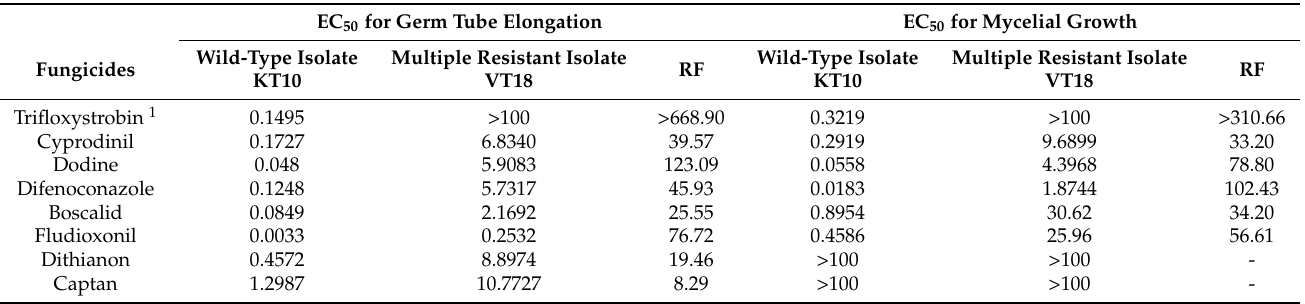
Table 2. Comparison of the germ tube elongation and mycelial growth of a sensitive and a multiple resistant V. inaequalis